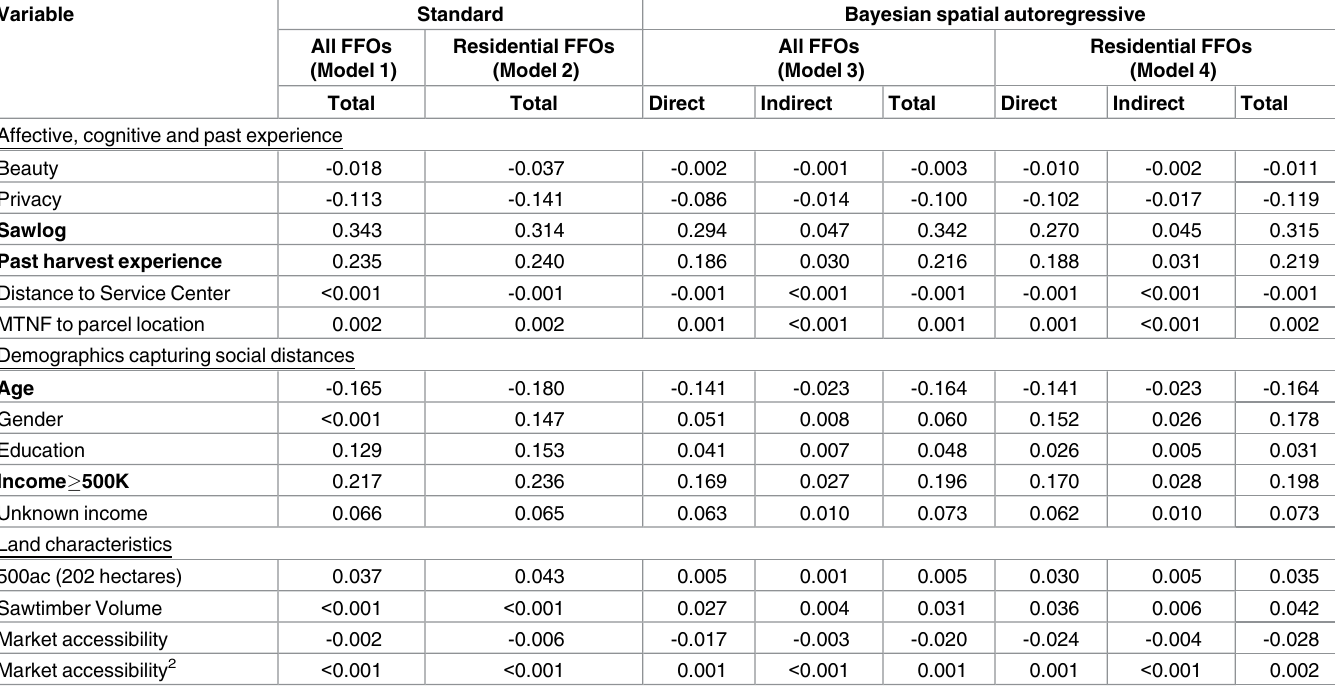
Table 3. Marginal effects on willingness-to-harvest probability from Standard and Bayesianspatial autoregressive probit models *